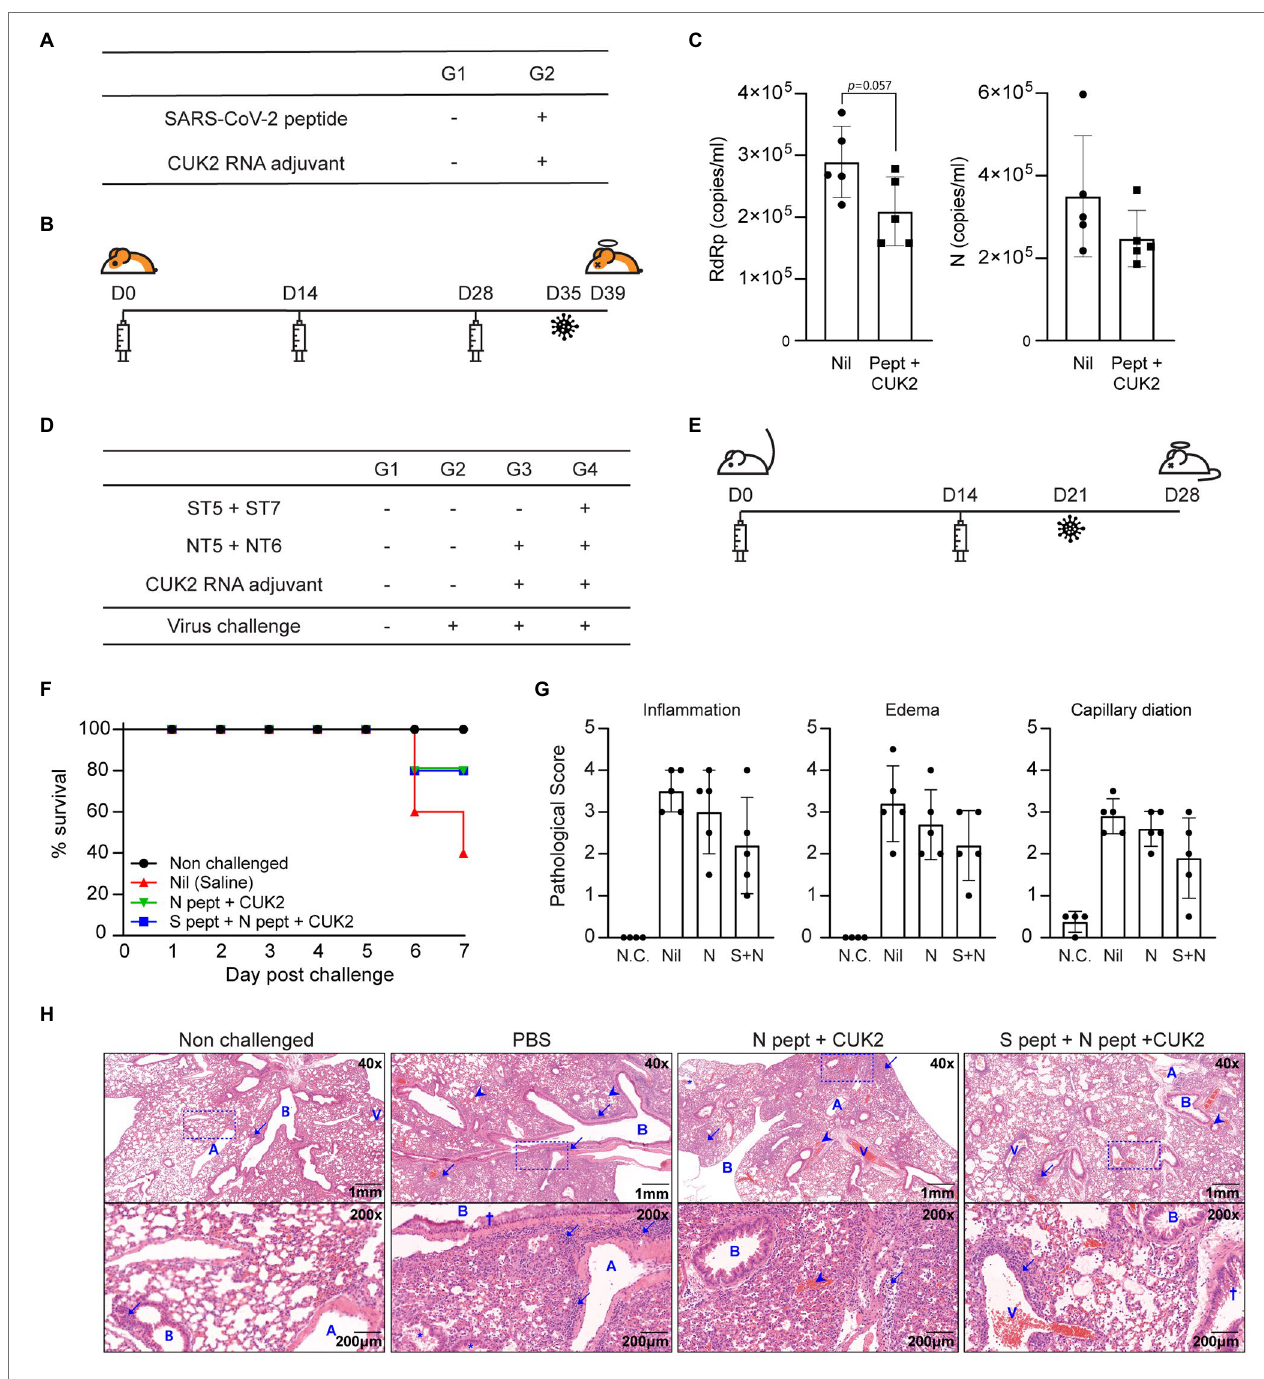
FIGURE 6 | Immunization with SARS-CoV-2 peptides partially reduced the viral titer in hamsters and conferred protection to hACE2 mice against SARS-CoV-2 infection. (A) Overview of the experimental groups. (B) Immunization and virus challenge schedule. (C) Real-time PCR of viral genomic RNA in the lungs. Data are presented as mean ± SD. (D) Overview of the experimental groups. (E) Immunization and virus challenge schedule. (F) Survival rates of the hACE2 Tg mice after SARS-CoV-2 challenge. (G) Pathological scores of lungs 7 days after challenge. (H) Representative histological images of hematoxylin and eosin-stained lung tissue sections. A, pulmonary artery; B, bronchus or bronchi; and V, pulmonary vein. Arrows indicate inflammatory cells (neutrophils and lymphocytes), arrowheads indicate hemorrhage, and the crosses indicate mucus. Data represent mean ±